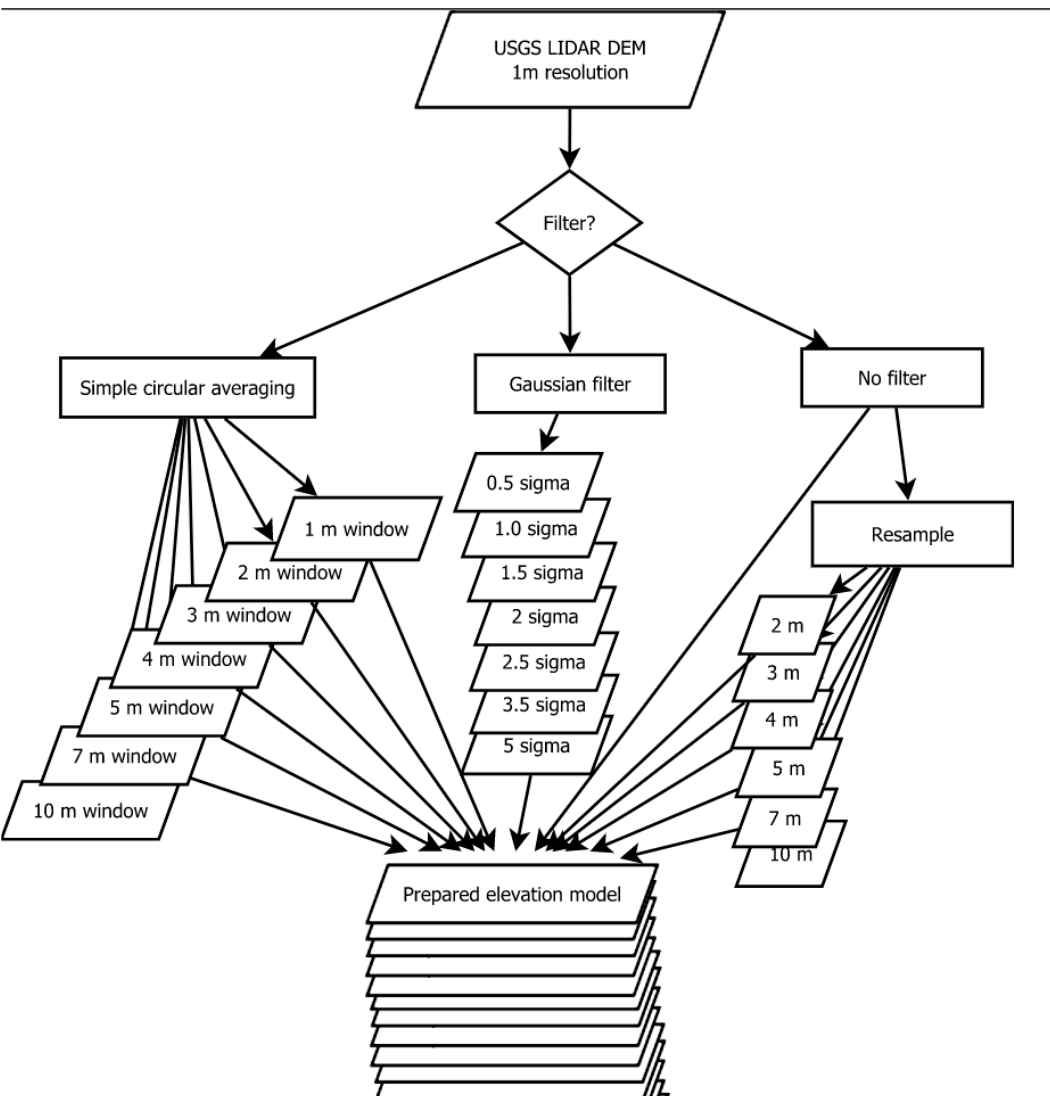
Figure 2. The process of preparing the 21 digital elevation models for the study site. A common practice when preparing digital elevation models for hydrological terrain analysis is flow path enforcement through the removal of spurious pits and peaks,